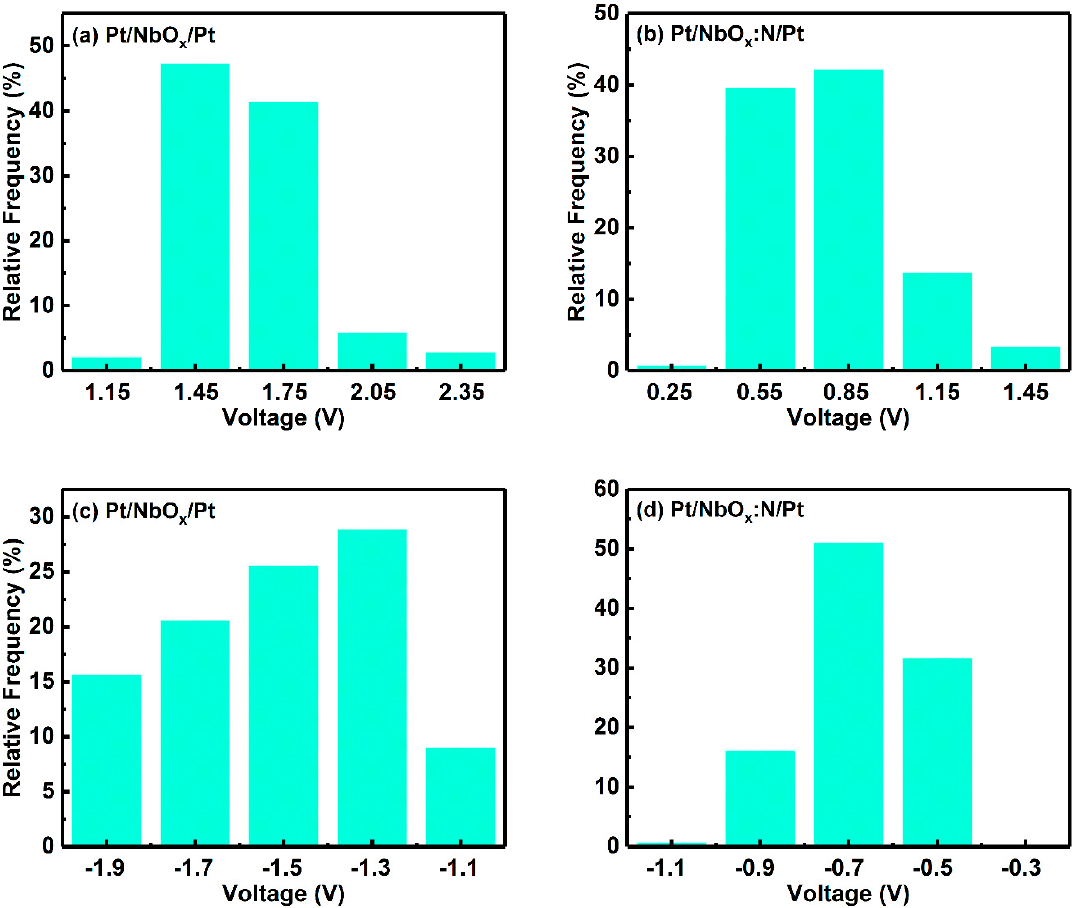
Figure 6. Distribution of SET voltage for ( a ) Pt/NbO x /Pt and ( b ) Pt/NbO x :N/Pt memory devices. Distribution of RESET voltage for ( c ) Pt/NbO x /Pt and ( d ) Pt/NbO x :N/Pt memory devices.